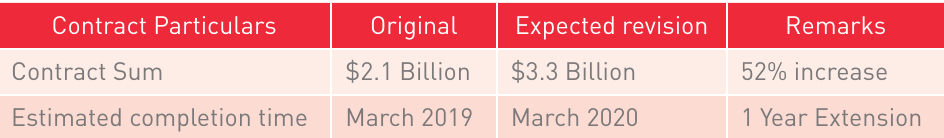
Comparison of agreed project cost and time against the contractor’s